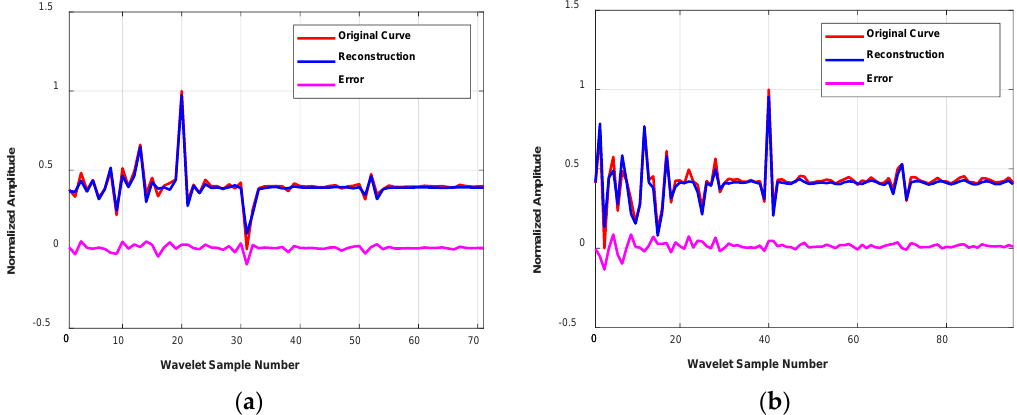
Figure 8. Reconstructions operated by S-AEs on Samples from Set B of the ECG-ID and the MIT-BIH-AHA. ( a ) Comparison between original and reconstructed curves of wavelet feature of Beat 1 from the MIT-BIH-AHA database, Record-100; ( b ) Comparison between original and reconstructed curves of wavelet feature of Beat 1 from the ECG-ID database, Record-1.